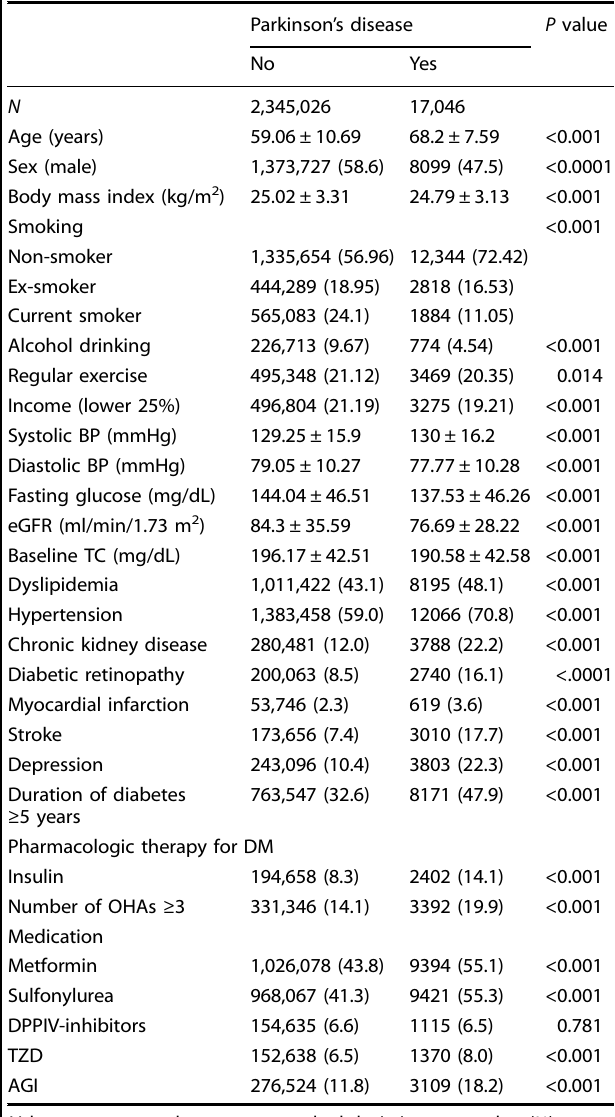
Table 1. Study subjects ’ baseline